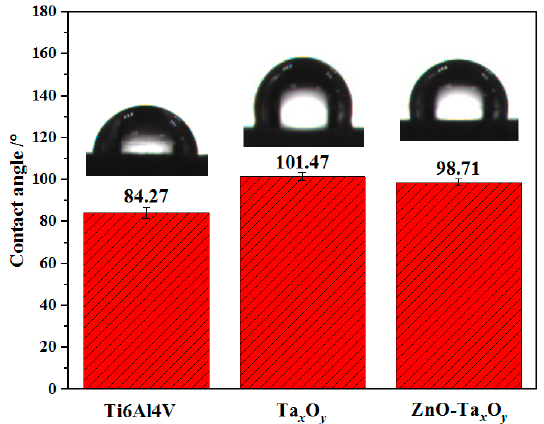
Figure 11. Contact angle measured for un-coated and coated Ti6Al4V samples.